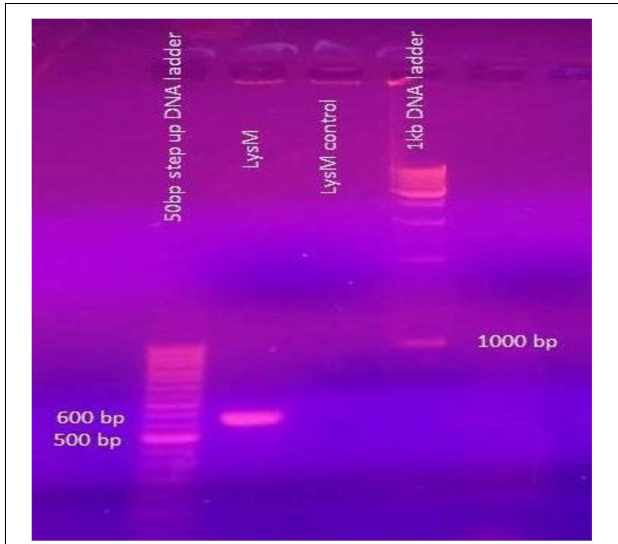
FIGURE 4 | From the left. Lane 1 50bp step-up DNA ladder; Lane 2 574bp amplified fragment of LysM gene; Lane 3. Control reaction showing no amplification, Lane 4 1kbp DNA ladder.